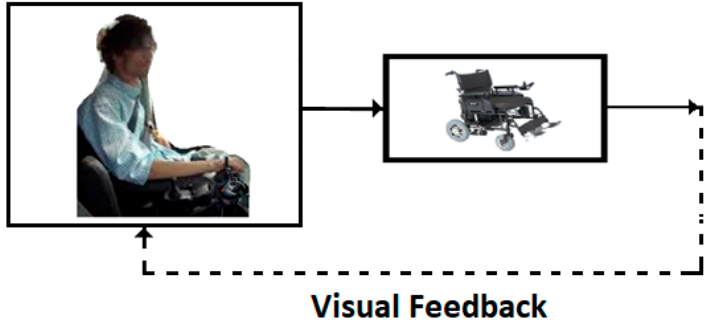
Figure 6. Wheelchair control for a person with health problems.